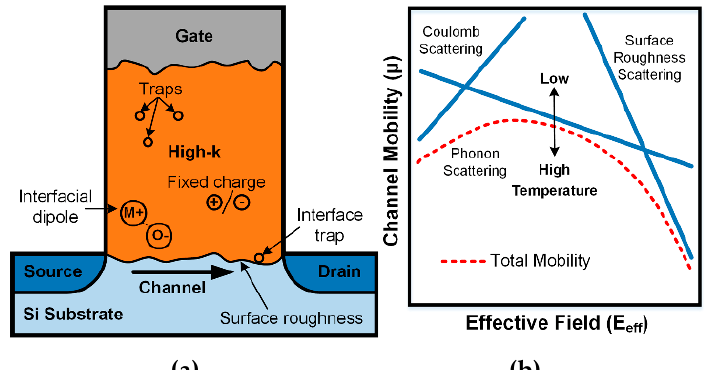
Figure 8. ( a ) Schematic diagram demonstrating the origins of mobility degradation in MOSFET. ( b ) Factors that impact carrier mobility.